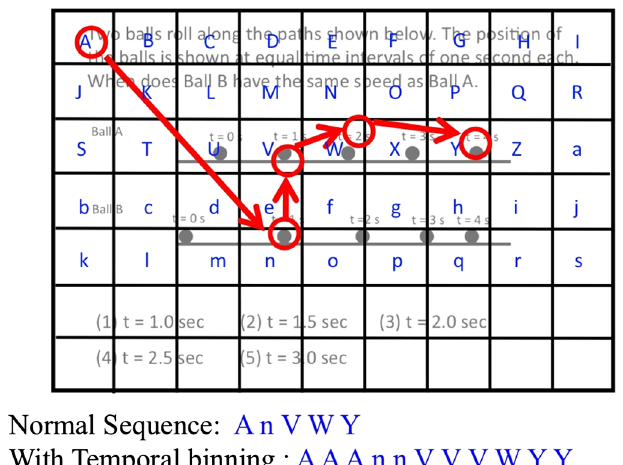
FIG. 7 (color online). Example of ScanMatch algorithm con- verting a scan path into the letter sequence which was used to calculate the similarity score. Red circles represent fixations, red arrows represent saccades.